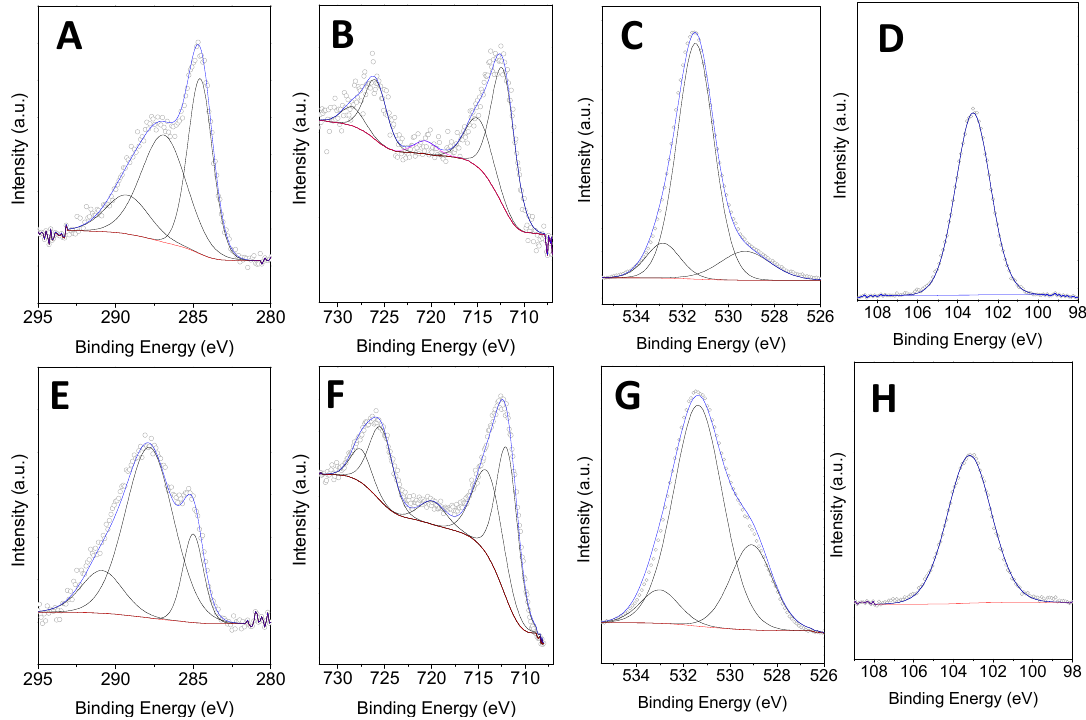
Figure 3. TEM images of ( A ) 40% FeMagC at 400 °C, and ( B ) 40% FeMagN at 400 °C.